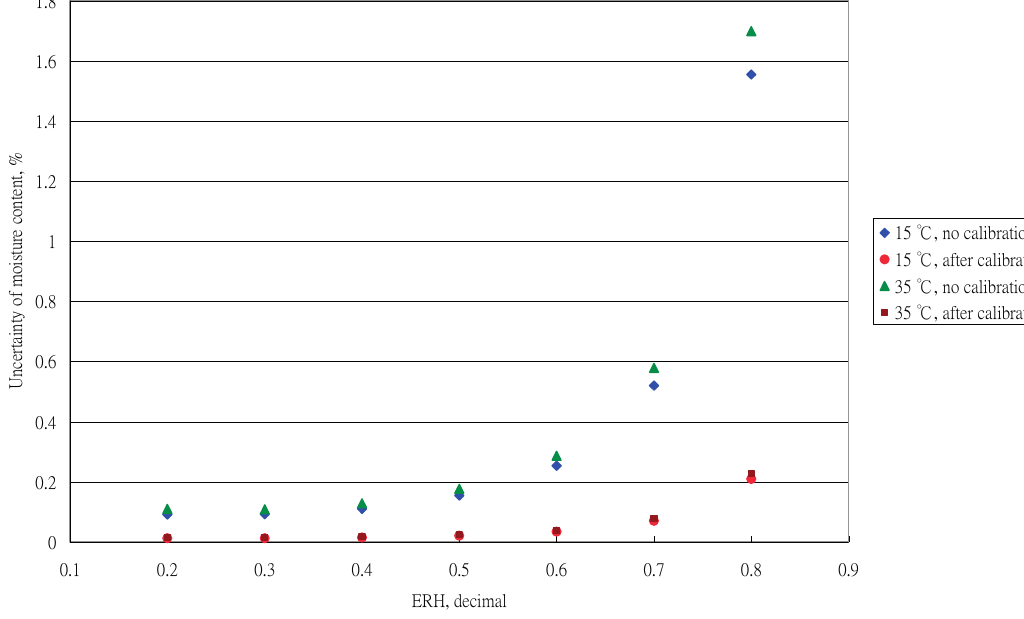
Figure 7. Effect of the sensor performance on the moisture uncertainty